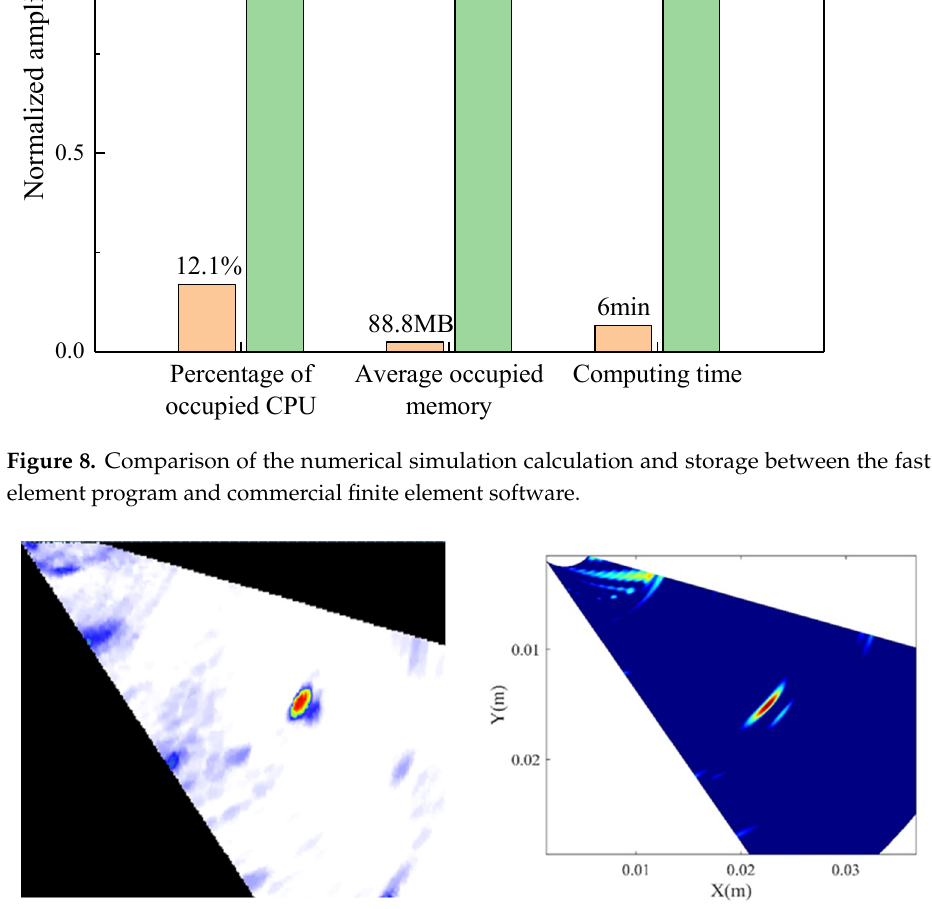
( b ) Figure 9. Phased array fan scan image in ( a ) the real experiment and ( b ) the simulation.